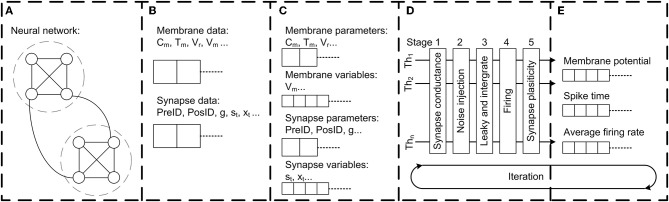
The architecture of the Flysim simulator. In the fruit fly brain model, each neuron and synaptic connection are unique. Therefore, the entire model requires a large amount of computer memory. The simulator is designed to address this challenge. (A) The simulator first goes through the network configuration file and estimates the number of neurons and synapses. Next, the simulator pre-allocates memory. (B) The simulator goes through the network configuration file again, reads all parameters, and then builds the whole network by filling each membrane-related and synapse-related datum into the pre-allocated memory. (C) The simulator performs linear reduction for synapse-related data to reduce computation and archive threading level parallelism. (D) The simulator dispatches each thread with one assembled neuron array and aligns each thread into a 5-stage pipeline for parallel processing. (E) Simulation results, including spike, membrane potential, average firing rate, and other data are directly accessed from assembled neuron arrays to archive high throughput and low latency data output.